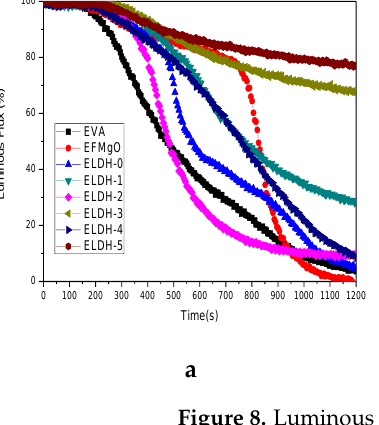
Table 3. LOI values and UL-94 results for EVA/LDHs composites.